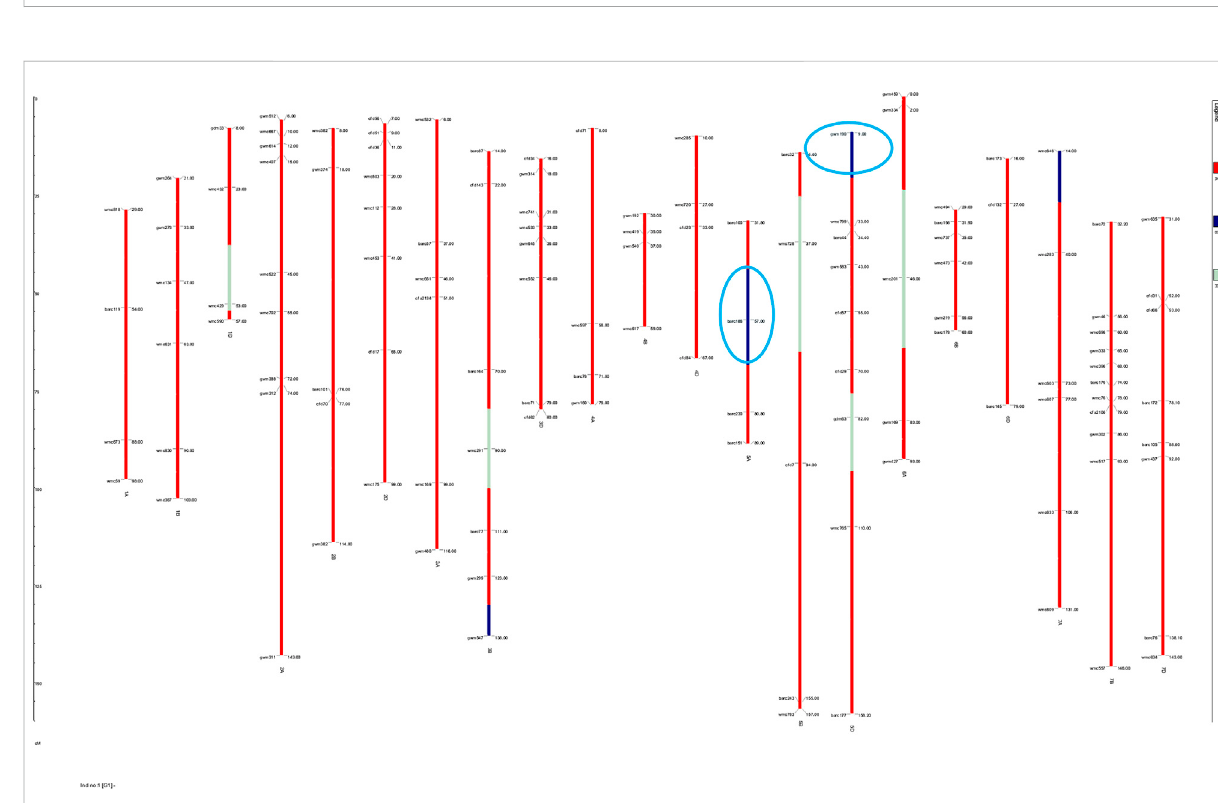
FIGURE 3 Graphical genotyping image of the best selected line with maximum genome recovery of RP and carrying both targeted